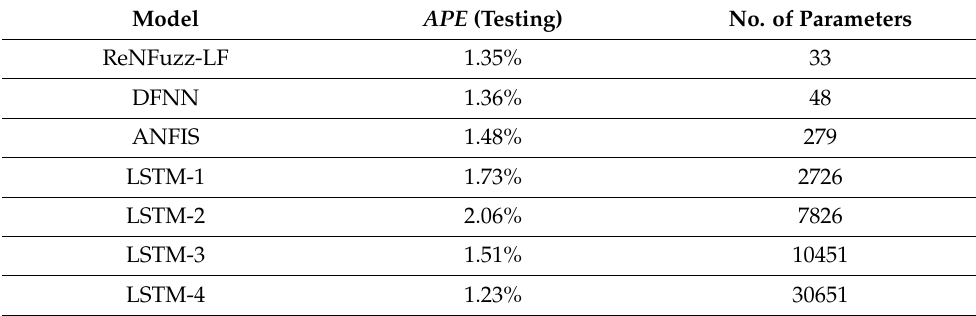
Table 7. Comparative